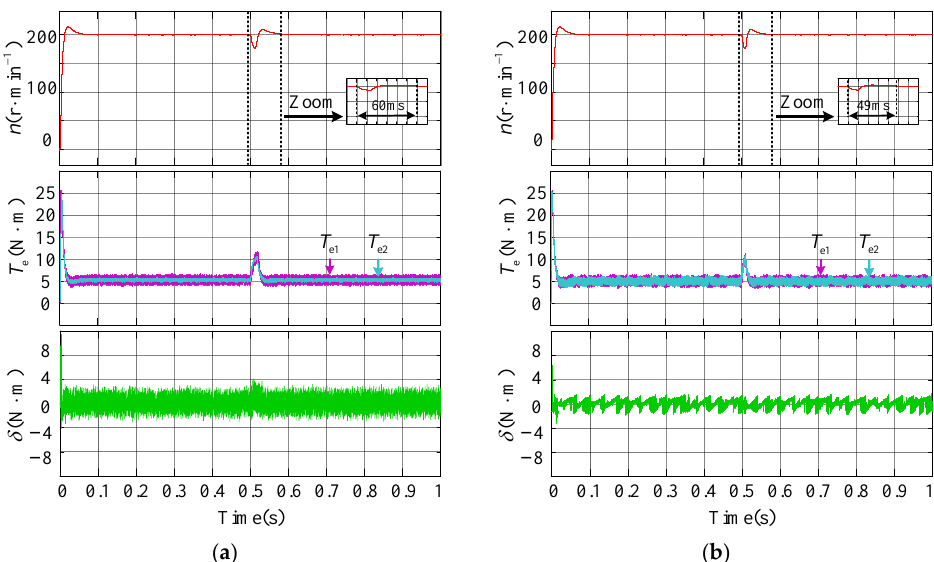
Figure 10. Simulation results for load torque disturbance with R s2 / R s1 = 1.3, L 2 / L 1 = 1.3: ( a ) the closed-loop control strategy and ( b ) the proposed FCS-MPC strategy.